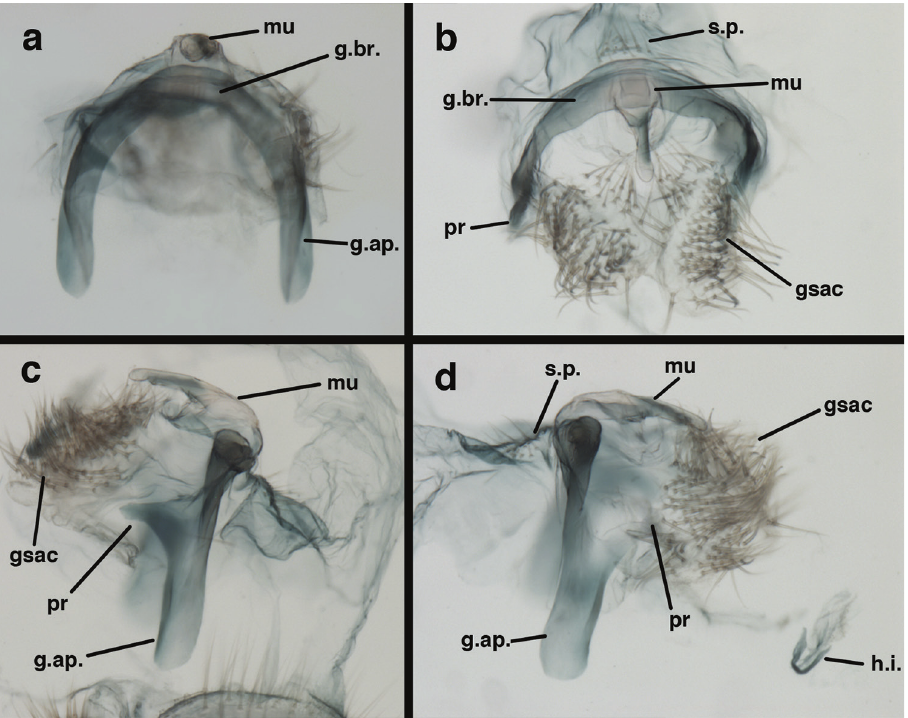
Figure 10. Ungla adamsi Tauber , sp. n. Male genitalia (slightly teneral), ( a ) gonarcus, posterior (mediun- cus extending into photo) ( b ) gonarcus, dorsofrontal ( c ) gonarcus, left, lateral ( d ) gonarcus, right, lateral. g.ap. gonarcal apodeme g.br. gonarcal bridge gsac gonosaccus h.i. hypandrium internum mu mediuncus pr unarticulated process on frontal margin of gonarcal apodeme s.p. setose subanal plate (all: Peru, Machu Picchu, paratype,